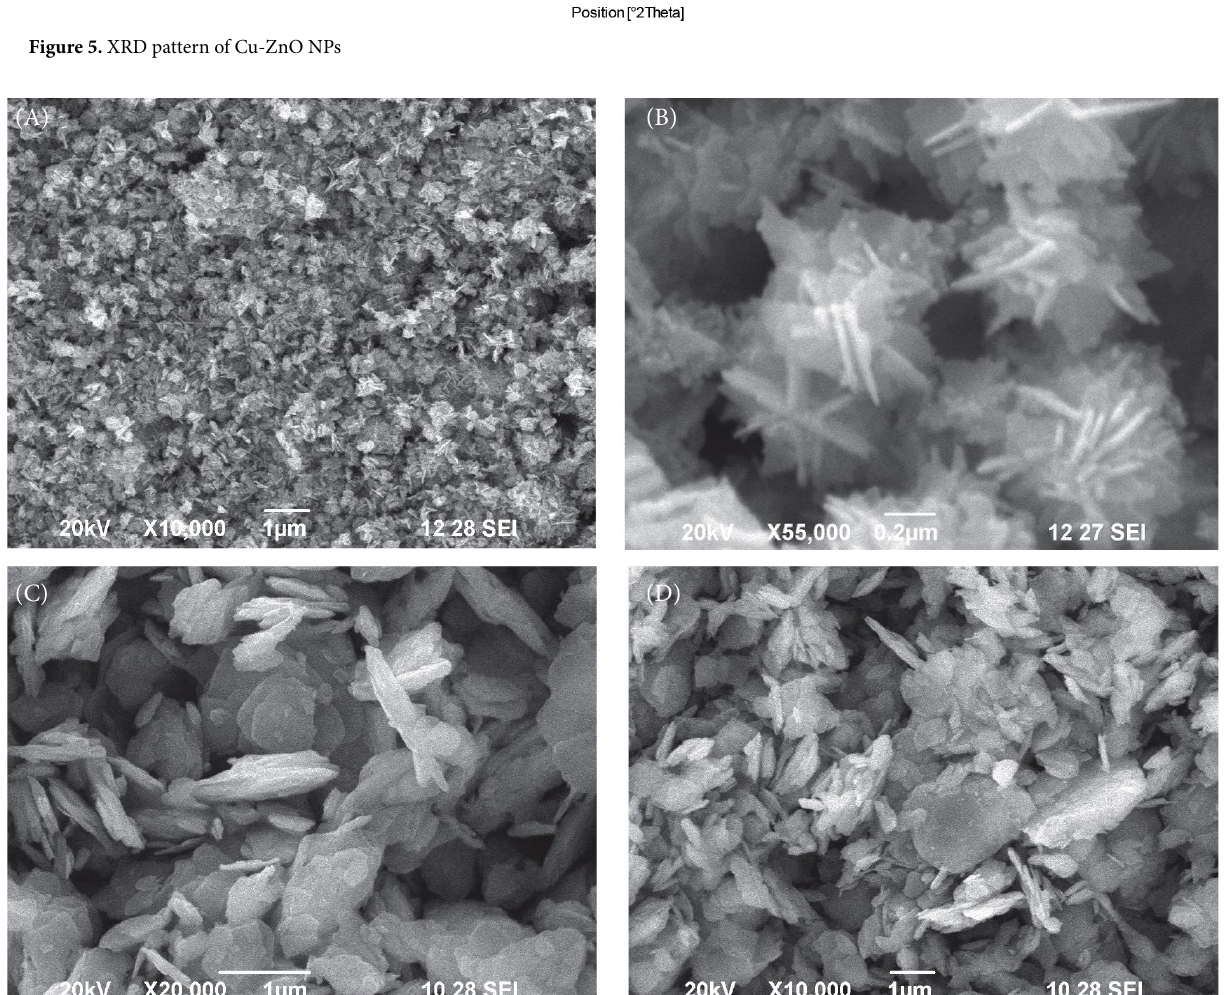
Figure 6. SEM images of ZnO (A) and Cu-ZnO (B-D)NPs at various